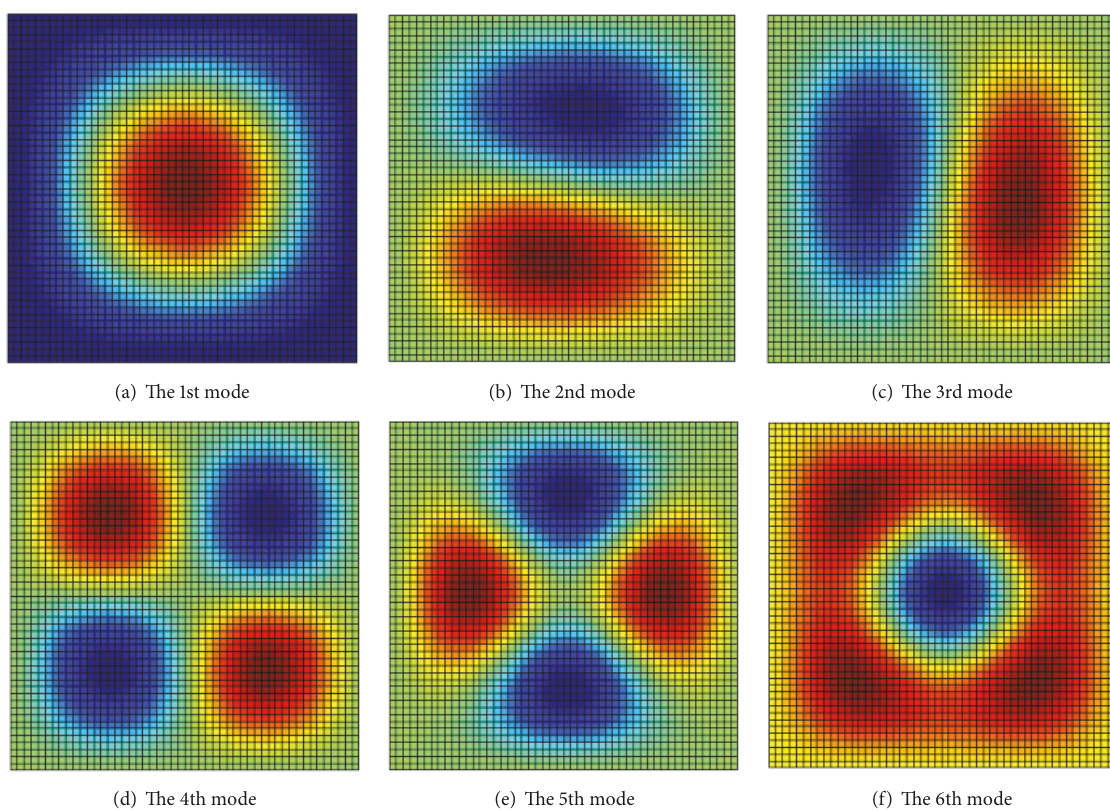
Figure 9: The first six mode shapes of square rectangular plates with multipoint support, calculated by the present